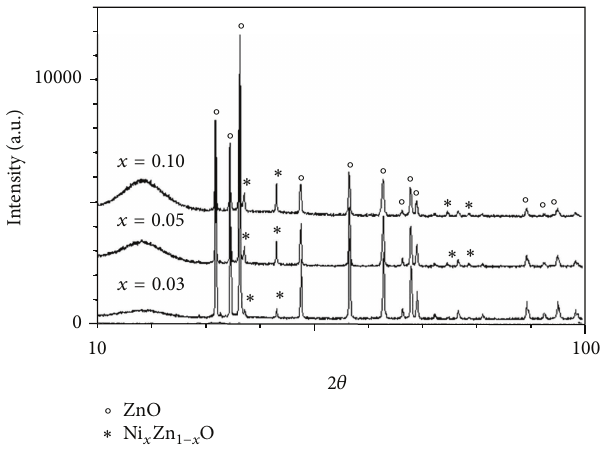
Figure 1: X-ray diffraction patterns of Zn 1−𝑥 Ni 𝑥 O ( 𝑥 = 0.03 ÷ 0.10 ) thin film